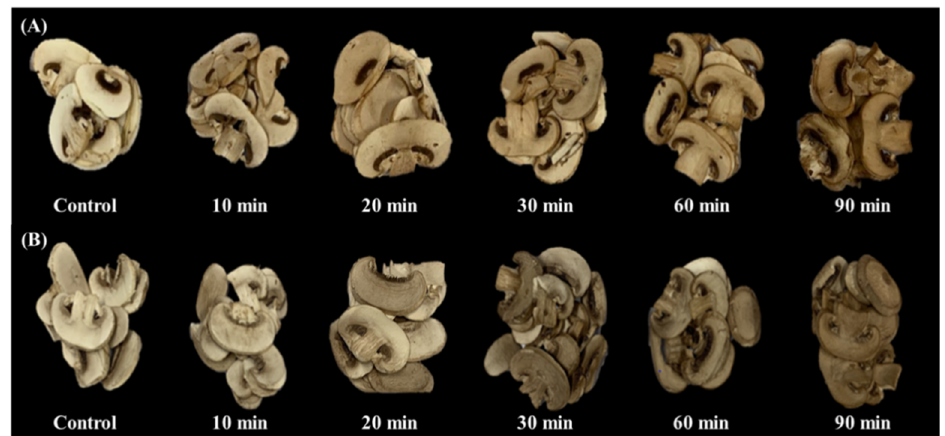
Figure 1. Sliced white button mushrooms ( Agaricus bisporus ) treated with UV-B for various times ( A ); the appearance of the control and UV-B-treated mushrooms after freeze-drying ( B ).